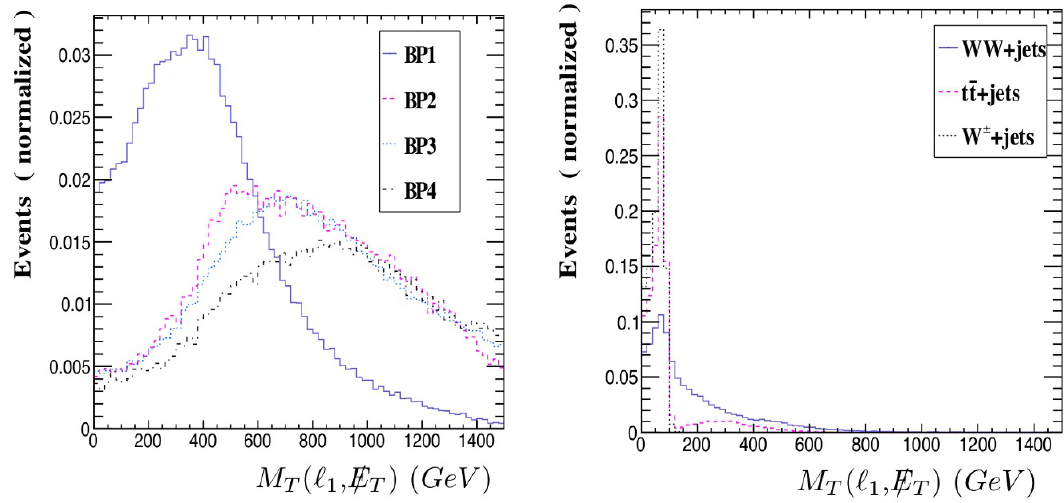
Figure 3 . Distribution in the transverse mass M T of the leading lepton and the missing transverse momentum for the di(cid:11)erent benchmark point signals (left) and for the SM background (right). The distributions are shown after the basic acceptance selections de(cid:12)ned in the text and normalized to 1.